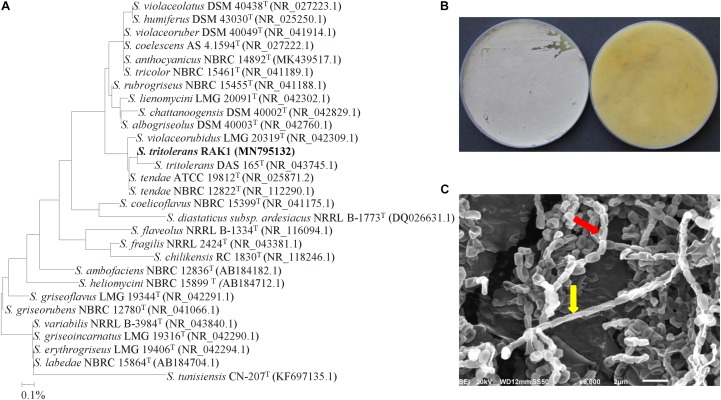
Identification of Streptomyces tritolerans RAK1 based on phylogenetic, cultural and morphological characteristics. (A) The tree showing the phylogenetic relationships between the polyamine-producing S. tritolerans RAK1 (isolate #7; MN795132; 1,516 bp) and other members of Streptomyces spp. on the basis of 16S rRNA sequences. (B) Aerial mycelia (left) and substrate mycelia (right) growing on ISP3 medium supplemented with yeast extract; and (C) scanning electron micrograph (6,000X) showing closed straight to flexuous (rectus-flexibilis) chains of spores (red arrow) with smooth spore structure (yellow arrow) of the strain of S. tritolerans RAK1. In (A) numbers at nodes indicate percentage levels of bootstrap support based on a neighbor-joining analysis of 1000 resampled datasets. Bar, 0.001 substitutions per site. GenBank accession numbers are given in parentheses.